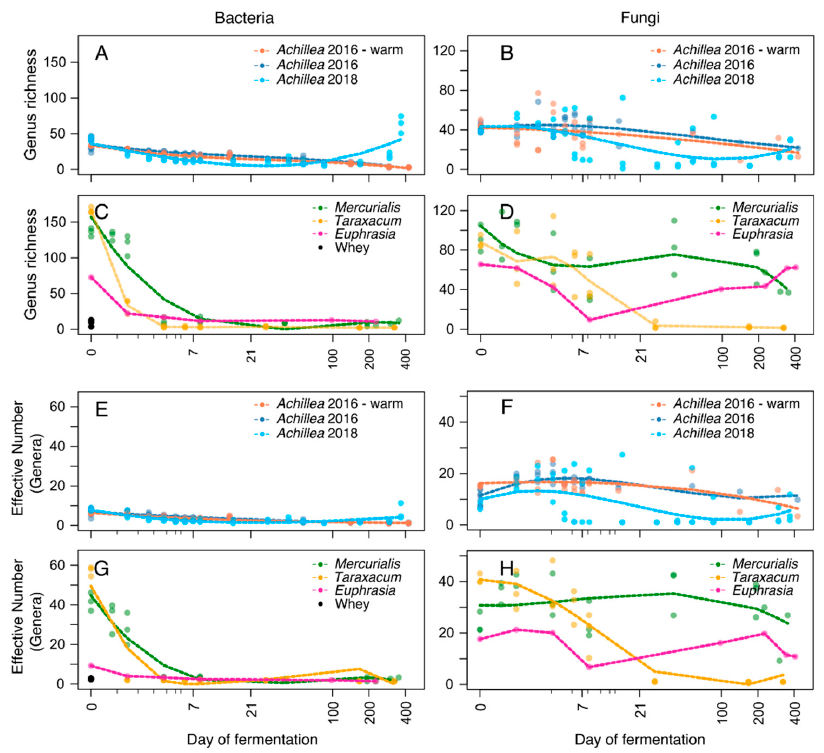
Figure 3. Richness and effective number of bacterial and fungal genera during fermentation, accord- ing to the GHP of Achillea , ( A , B , E , F ) and Mercurialis , Taraxacum , and Euphrasia ( C , D , G , H ). Achillea 2016 was also fermented at permanently warm conditions ( Achillea 2016—warm) during the initial 7 days. Richness and effective number of the whey-associated bacterial community is shown as black dots on panels ( C , G ). Note the log-scale of the time axis. Each dataset was subsampled to 1000 reads per